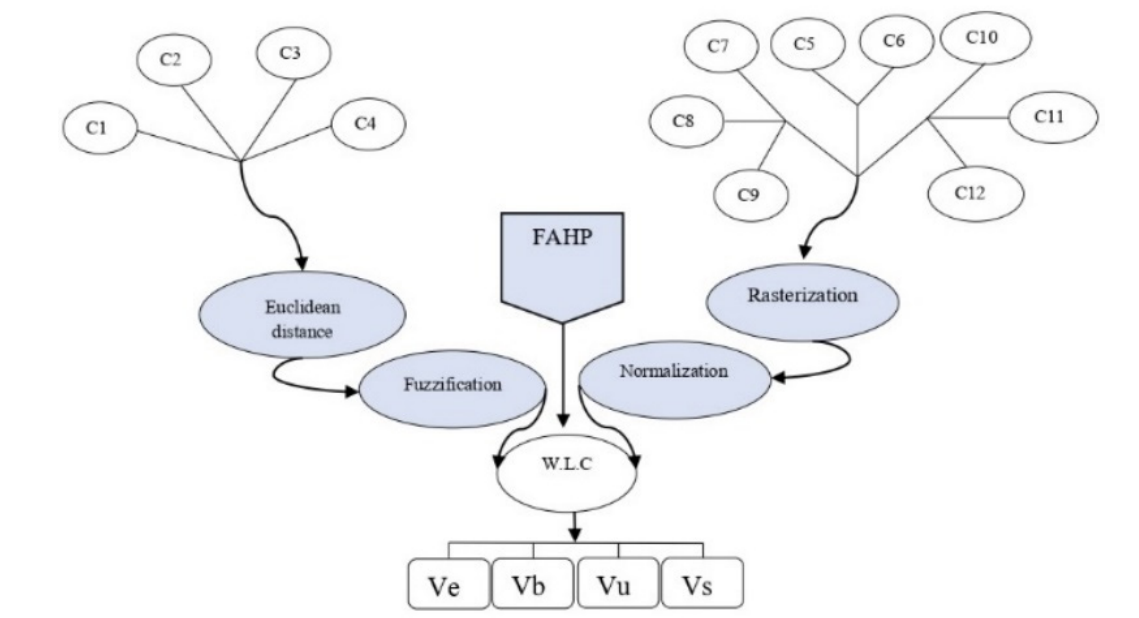
Figure 4. Flowchart of the methods used to produce vulnerability indicators: environment (Ve), urban (Vu), building (Vb) and social (Vs).